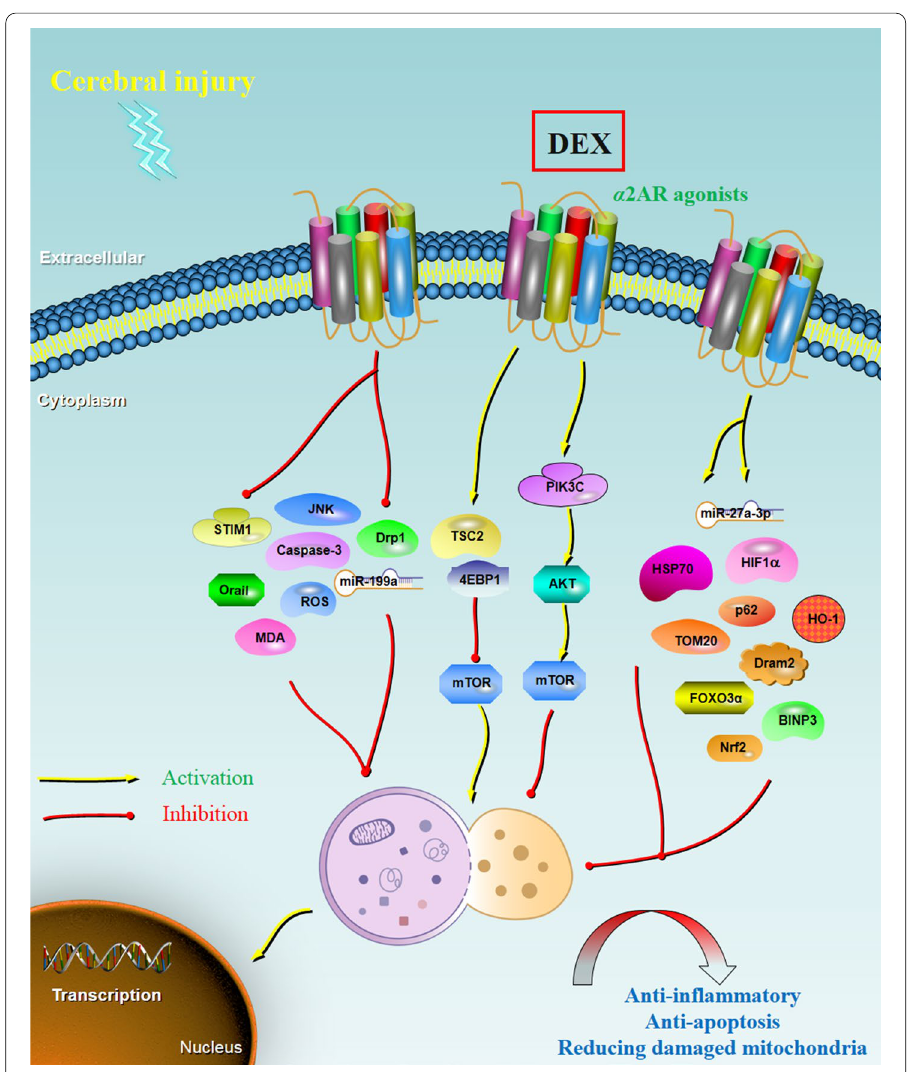
light chain 3 B, Drp1 dynamin-related protein 1, HSP70 heat shock 70 kDa protein, TOM20 translocase of outer mitochondrial membrane 20, Dram2 DNA damage regulated autophagy modulator 2, FOXO3α forkhead-box-protein 3α, TSC2 tuberous sclerosis complex 2, STIM1 stromal interaction molecule 1, ROS reactive oxygen species, MDA malondialdehyde, Nrf2 nuclear factor erythroid 2-related factor